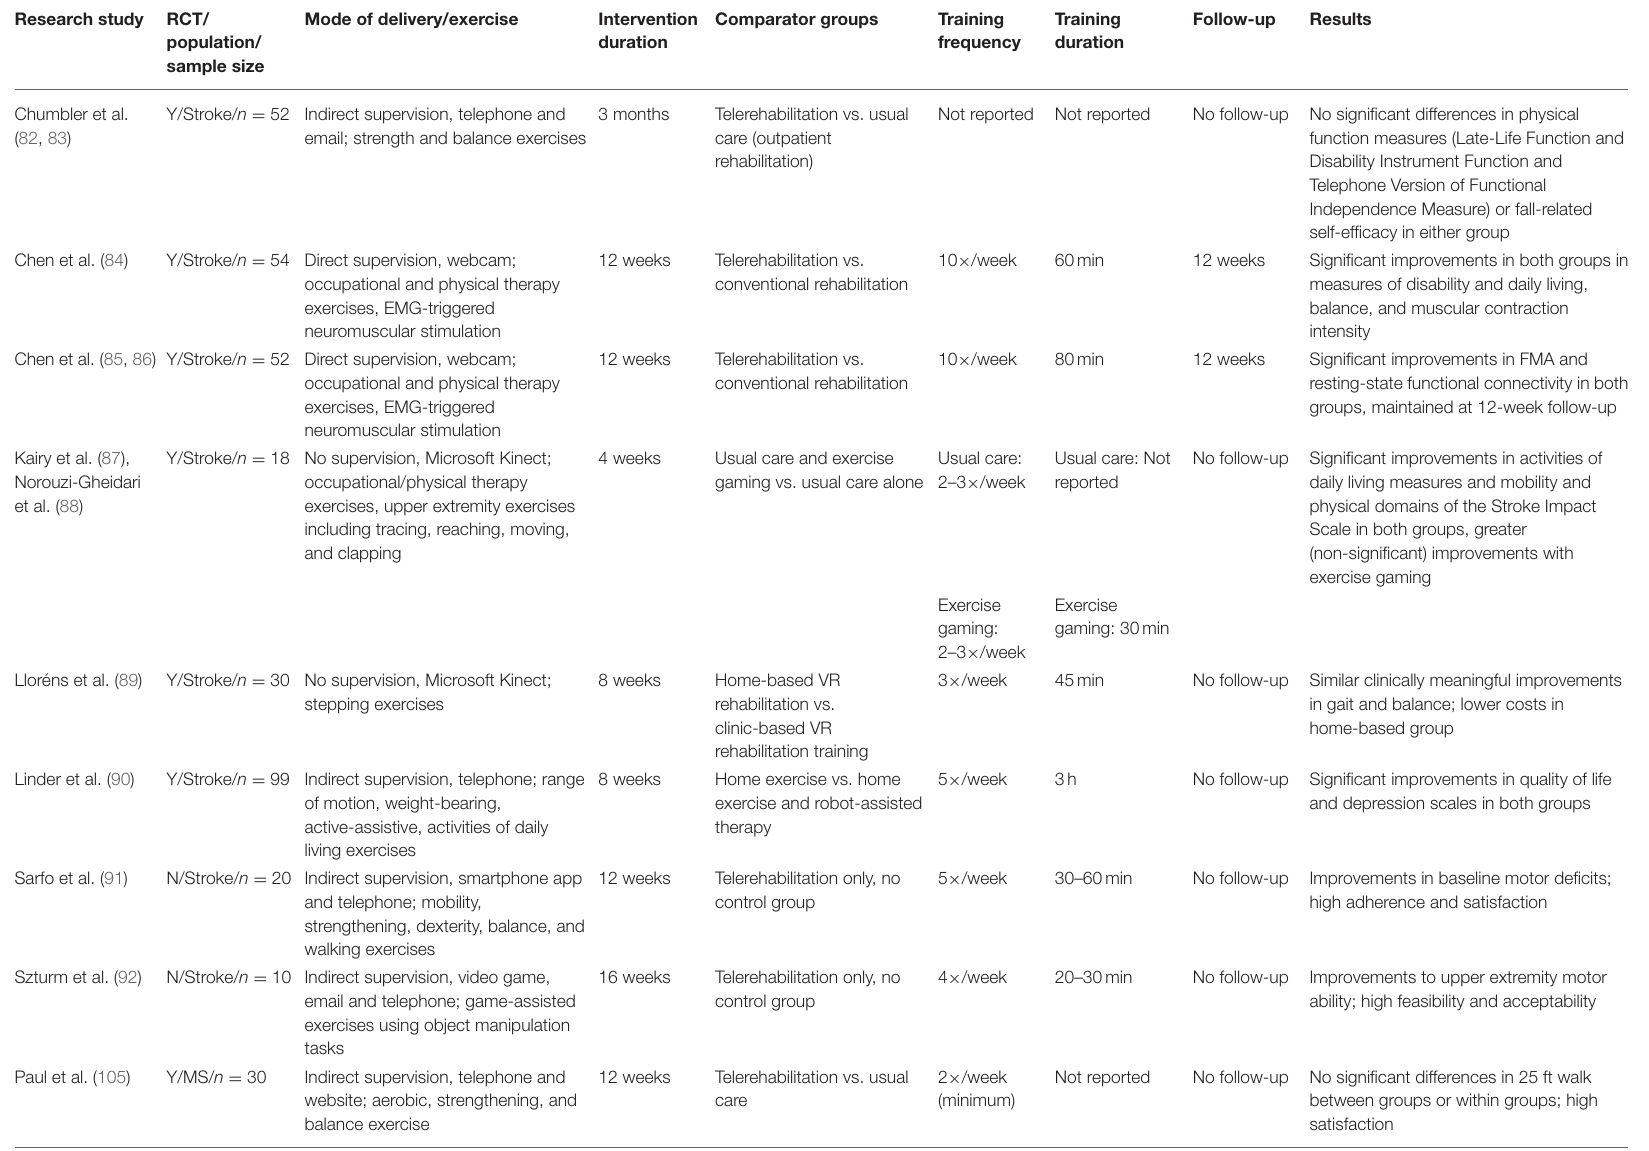
TABLE 3 | Characteristics and outcomes of home-based tele-exercise studies—neurological. Research study RCT/